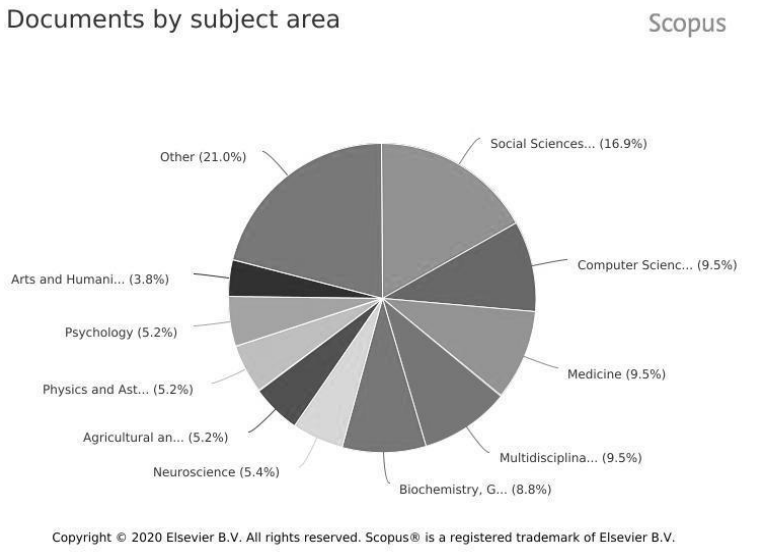
Fig. 4 Open Access publications by subject area (1979-2019). Source: